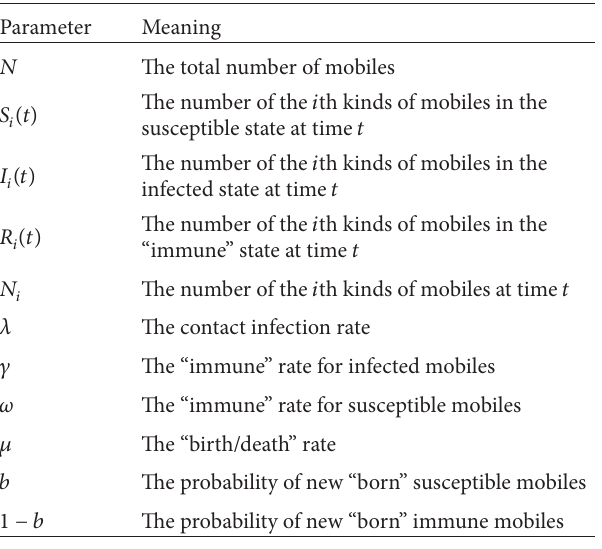
Table 2: Notations in the M-SIR